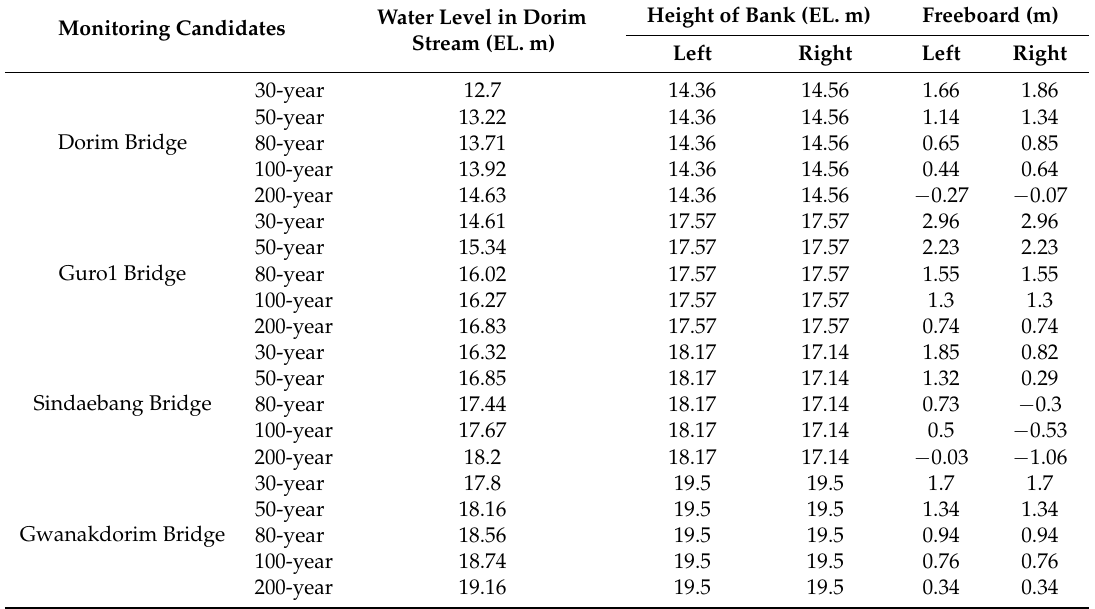
Figure 10. The monitoring candidates for the Dorim stream (Imagery © 2017 Centre National d’Etudes Spatiales/Astrium, DigitalGlobe, DigitalGlobe, Map data © SK telecom). Rainfall events with various frequencies (30, 50, 80, 100, and 200 years) and with a duration based on the time of concentration in the Dorim stream (360 min) were applied to select the monitoring nodes. The water level in the Dorim stream, height of the bank, and freeboard for events with 30-, 50-, 80-, 100-, and 200-year frequencies are shown in Table 8. Table 8. Information on the Dorim stream.